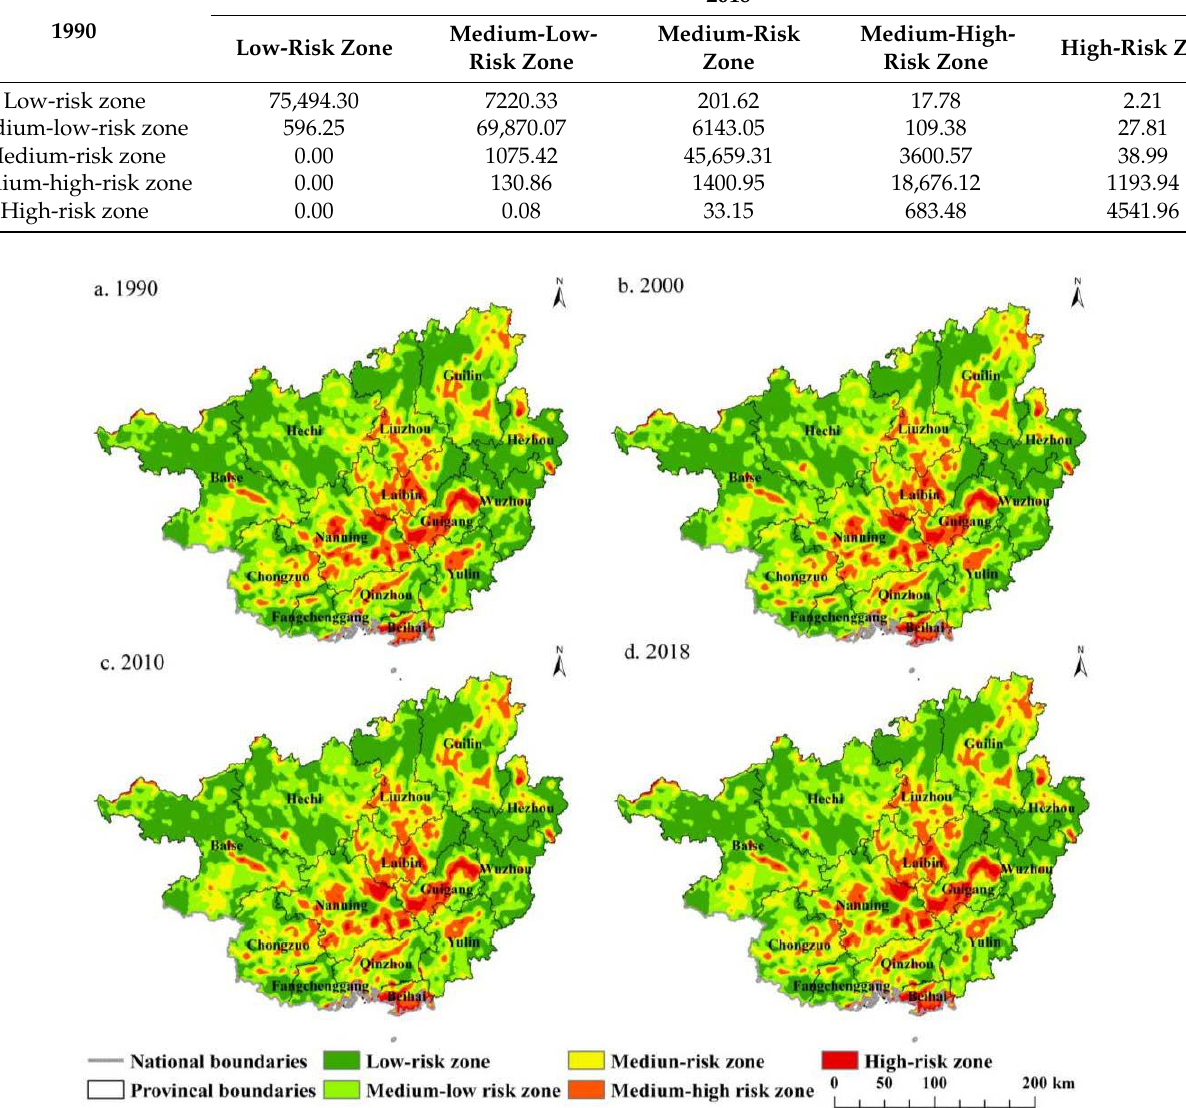
Figure 5. Spatial distributions of landscape ecological risk zones in Guangxi, China, during 1990–2018.